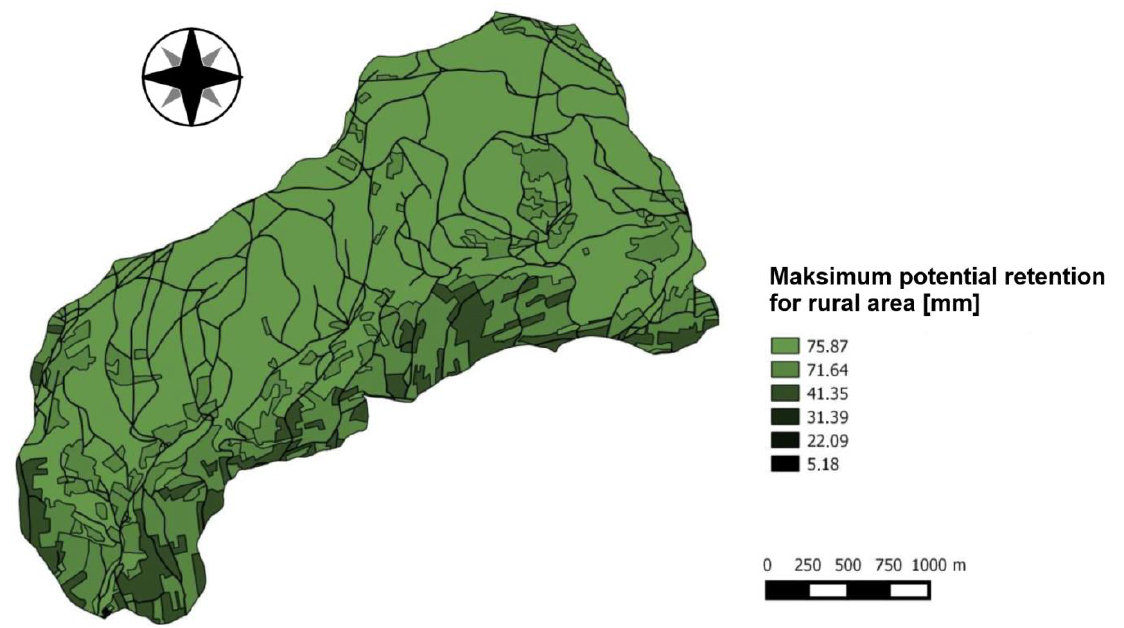
Figure 7. Maximum potential retention for suburban area.